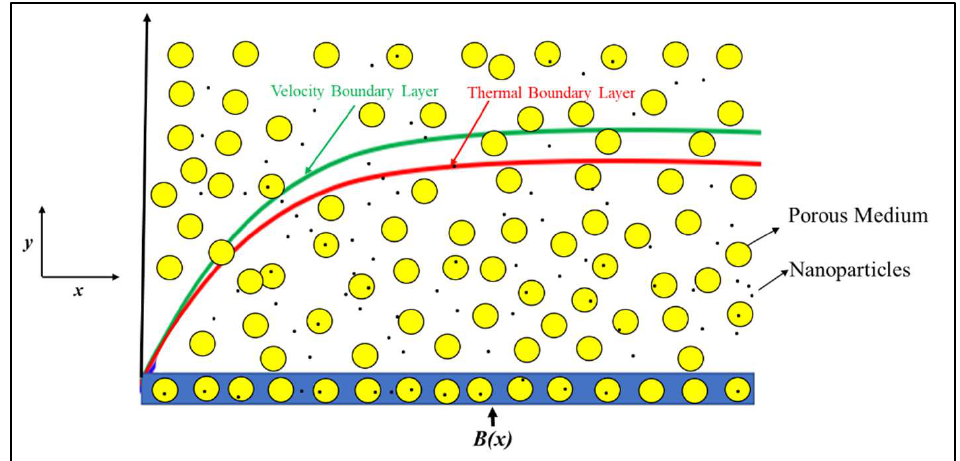
Figure 1. Model of nanofluid flow.